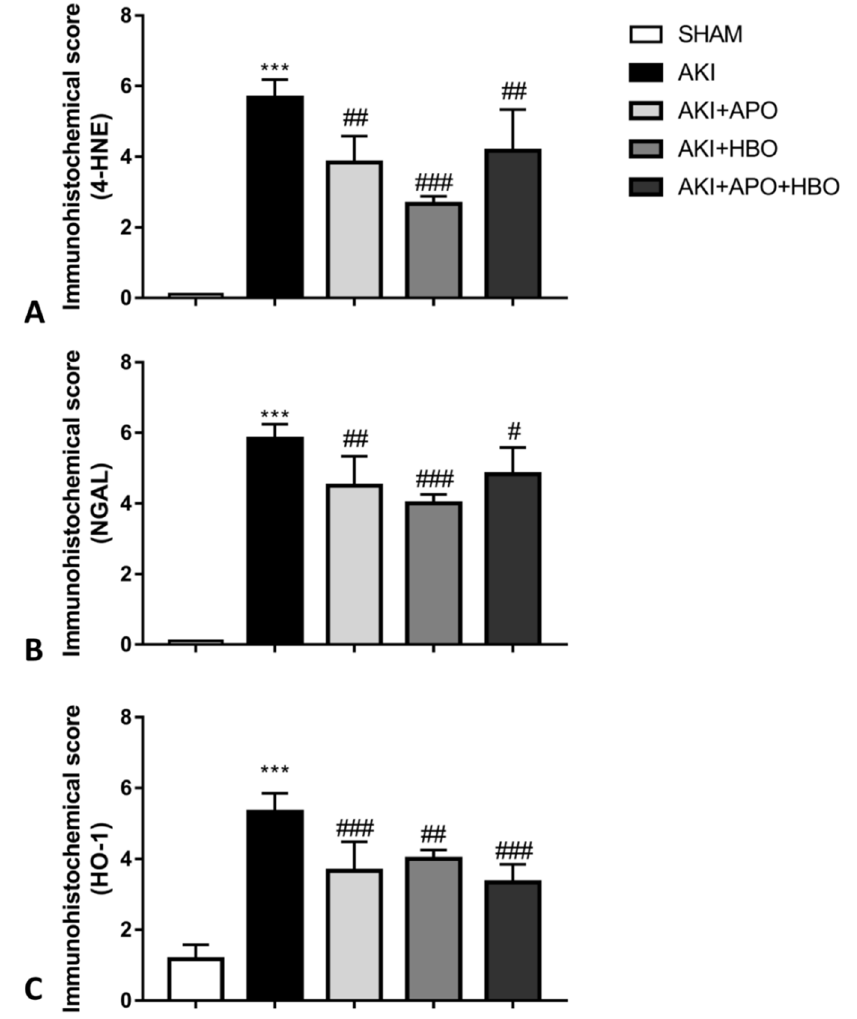
Figure 7. Immunohistochemical score of 4-hydrononenal (4-HNE) ( A ), neutrophil gelatinase- associated lipocalin (NGAL) ( B ) and heme-oxygenase-1 (HO-1) ( C ) expression; SHAM—sham- operated rats; AKI—rats with induced postischemic acute kidney injury; AKI + APO—animals with acute kidney injury and apocynin treatment; AKI + HBO—group exposed to HBO preconditioning before acute kidney injury induction; AKI + APO + HBO—animals exposed to HBO preconditioning before and treated with apocynin after acute kidney injury induction. Student’s t -test for independent samples (SHAM vs. AKI), one–way ANOVA with Dunnett’s multiple comparisons post hoc test (AKI vs. AKI + APO, AKI + HBO, AKI + APO + HBO);*** p < 0.001 vs. SHAM group; # p < 0.05, ## p < 0.01; ### p < 0.001.